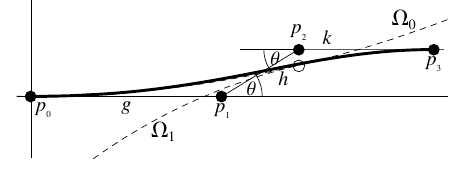
Figure 3. An S-shaped transition curve in normalized